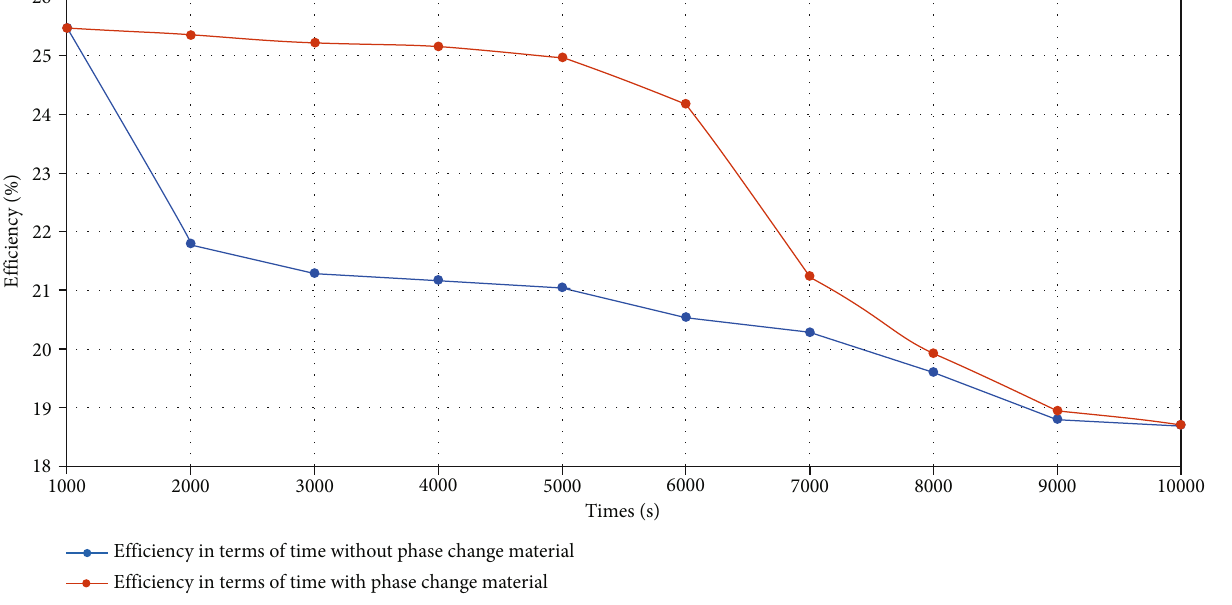
Figure 7: E ffi ciency in terms of time, assuming a radiation intensity of 1000 watts per square meter in the state with and without the phase change